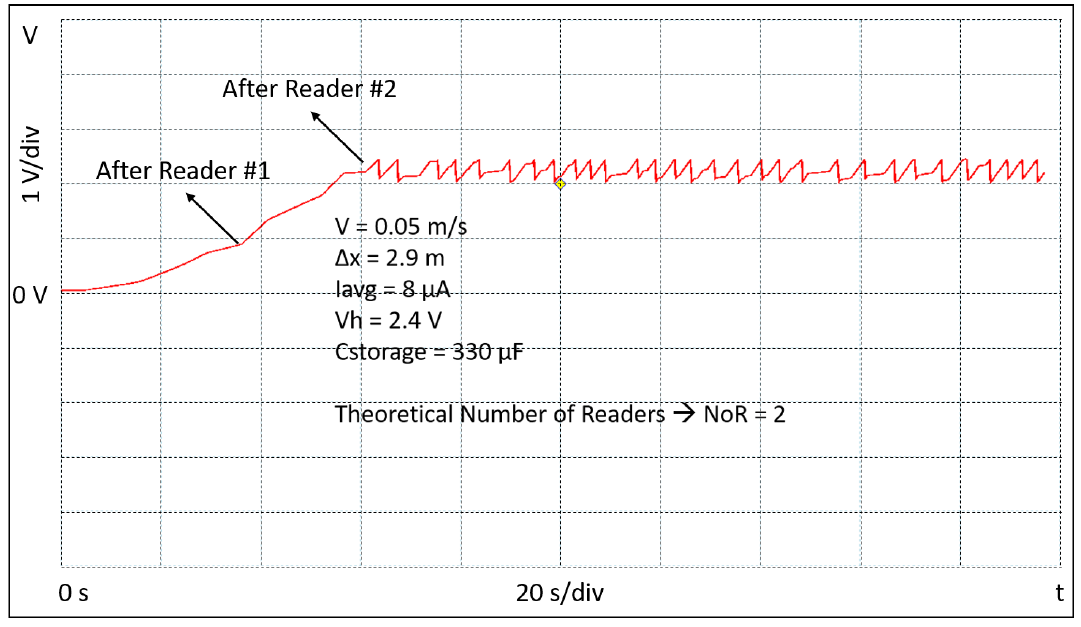
Figure 9. Experimental result of the tag crossing the readers at the speed of 0.05